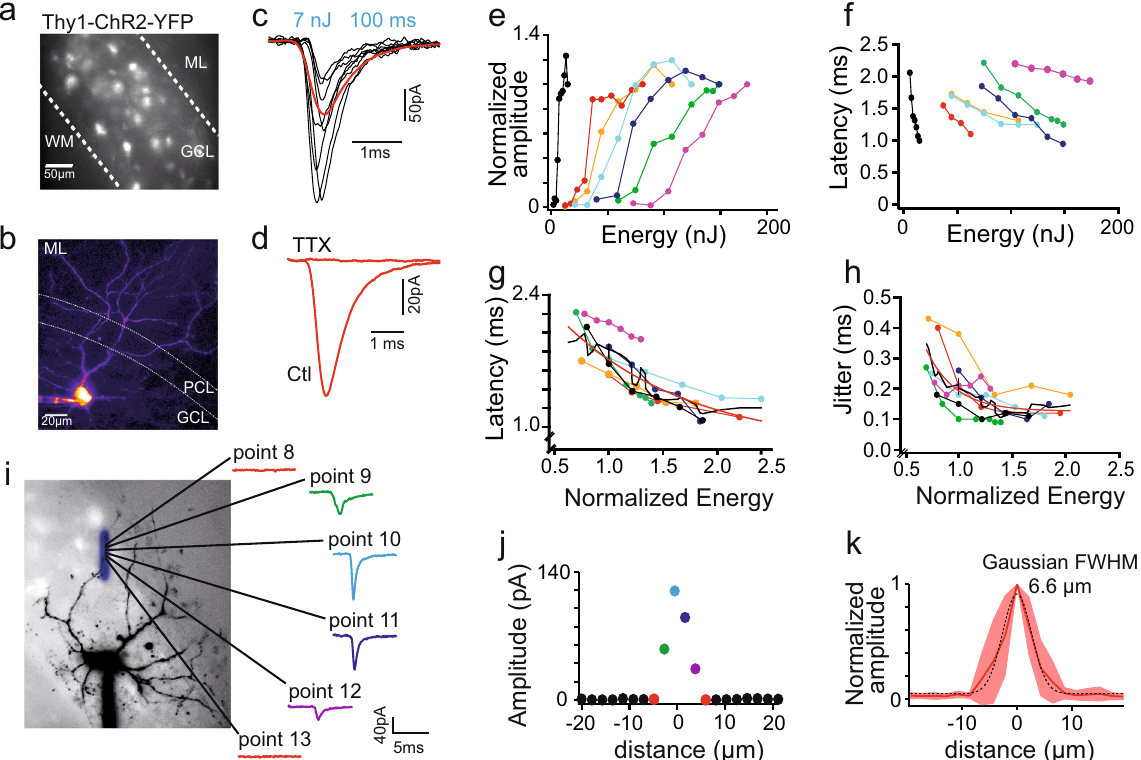
Figure 4. Optogenetic stimulation of single mossy fibers with submilisecond precision and spatial precision of low-NA Gaussian beam stimulation. ( a ) Fluorescence image of cerebellar slice from the vermis of a Thy1-ChR2- YFP mouse that expresses ChR2 and YFP in a subset of mossy fibers. ( b ) Two-photon image of the Golgi cell filled with Alexa 594 (15 µ M) via the recording pipette; GCL: granule cell layer, PCL: Purkinje cell layer; ML: molecular layer, WM: white matter. ( c ) Top panel: average EPSC (in red) evoked by the 100 µ s stimulation with examples of single events (in black). ( d ) Light evoked events are action-potential dependent since the response disappears in the presence of TTX (200 nM). ( e ) Energy response curve recorded in Golgi cells (n = 7). ( f ) EPSCs latencies (in ms) as a function of energy for each cell (color code the same as in e); latencies measured on averages from 100 events, EPSCs delay decreased with increasing laser power. ( g ) Light evoked events latencies (as in f) as a function of energy which was normalized to the half activation value, extracted from sigmoidal fit applied to the recruitment curves in e; values of the fit: start 2.06 ms, tau: 1.197, base: 0.78 ms. Color code as in e and f. ( h ) Jitter, defined as the standard deviation of the latency, as a function of energy, normalized as described in g. Values of the fit: start 0.327 ms, tau: 0.273, base: 0.126 ms. Color code the same as in e–g. ( i ) two-photon image of the Golgi cell recorded during spatial resolution experiment with the drawing of the accurate position of the stimulated points (superimposed in blue). The center of each point is marked with a black dot. On the right, examples of the evoked EPSCs in one cell showing no response (point 8 and point 13), response evoked at the edge of the mossy fiber (before and after the hotspot, point 9 and 12, respectively) and hotspot stimulation in point 10 and 11. Note decreased latency of the events at the hotspot in comparison to the spot located at the edge of the fiber. ( j ) Graph showing the amplitude of the evoked EPSCs as a function of distance for the example cell in c; colors of the spots on the graph correspond to the points in a. k . Summary graph showing the relative amplitude (normalized to the maximal amplitude for each cell) of the evoked events as a function of distance, zeroed at the hotspot (maximal evoked amplitude). Shaded area around the average (solid red line) represents ± s.d.; n =